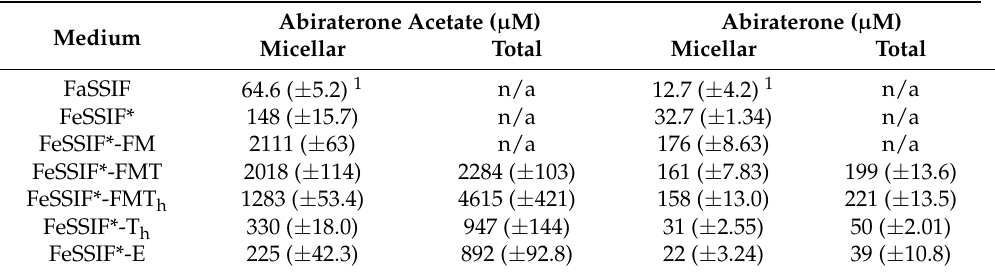
Table 2. Apparent solubility of abiraterone acetate and abiraterone in simulated media reflecting the fed state (pH 6.5). In case a lipid layer was present, solubility was determined in both the total sample (micellar + lipid layer) and micellar layer. Results are expressed as mean ± SD (n = 3). Abiraterone Acetate ( µ M) Abiraterone ( µ M) Medium